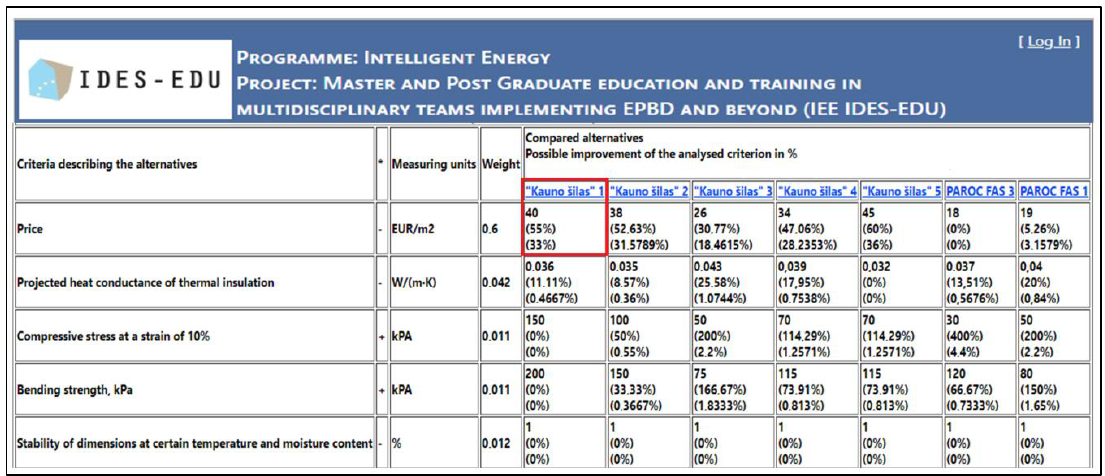
Figure 6. The “Kauno šilas 1” insulation market value analysis. As an analysis is completed for all the elements (insulation of walls and roof, nano-structured grout, windows, doors, heat recovery units, and renewable energy devices (solar collectors, windmills, geothermal boilers)), the alternative combinations of energy-efficient solutions are automatically developed and ranked, and the best alternative combinations are presented (see Figure 7). In this case, the NANSEN has developed 16,329,600 alternative combinations. Figure 7 illustrates final calculation results; the best combination is highlighted in red. NANSEN recommends the user to manufacture windows at the company “Baltijos langai”, incorporate “TGE - Electrochrome” smart glasses, to select doors from “Fortas”, to use “PAROC FAS 1” wall insulation and “EUROMAC2 MTP2- 46” roof insulation, to install “LGH - 50RX5” energy recovery system, “WATT 3000 S” solar panels, “GMSW 10 plius” geothermal boiler, to choose walls with smart elements and to use “FUGA NANOTHECH 730” nano-structured grout.